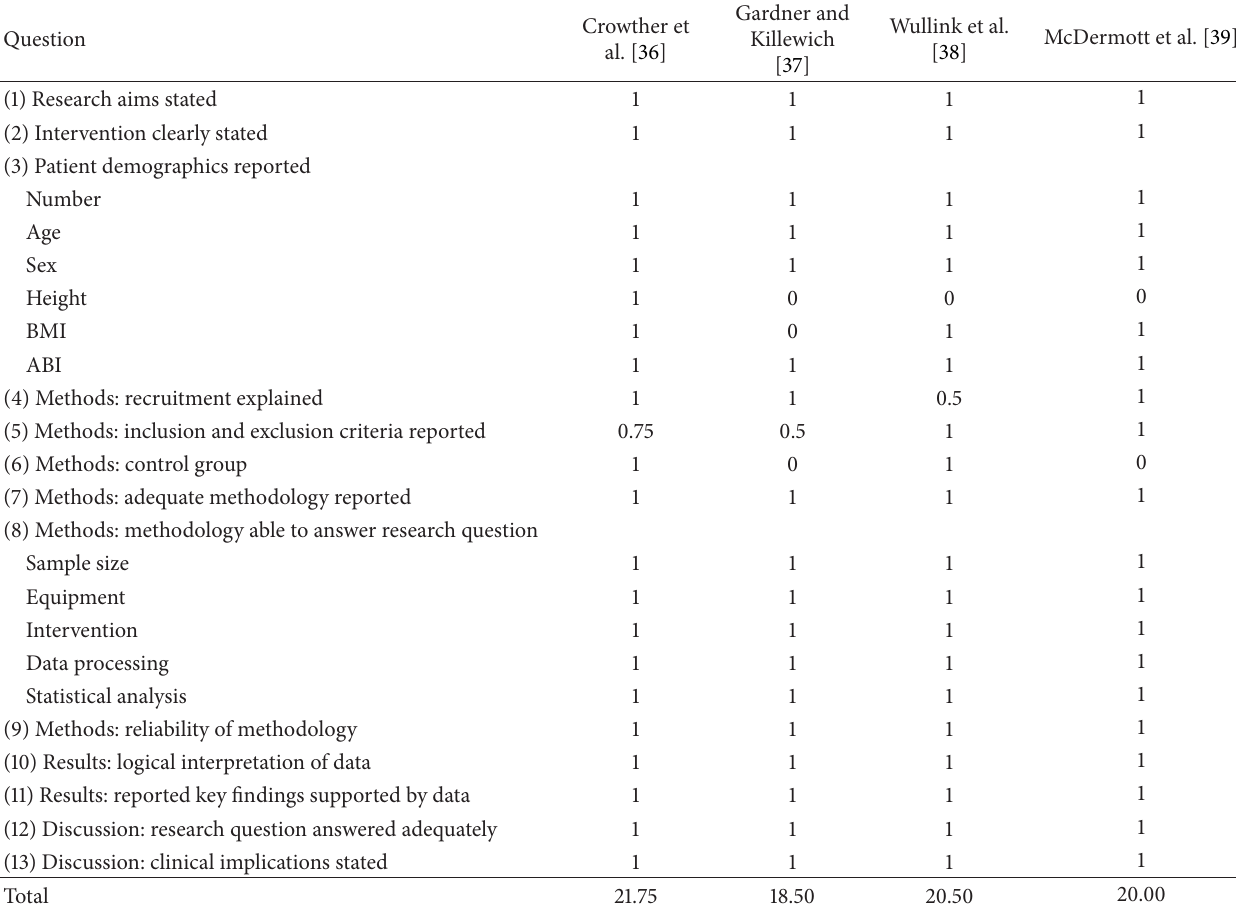
Table 1: Summary of quality assessment for individual articles. The four articles shown are those selected for detailed review. Scoring criteria employed: Yes, 1; inadequate, 0.5; no,